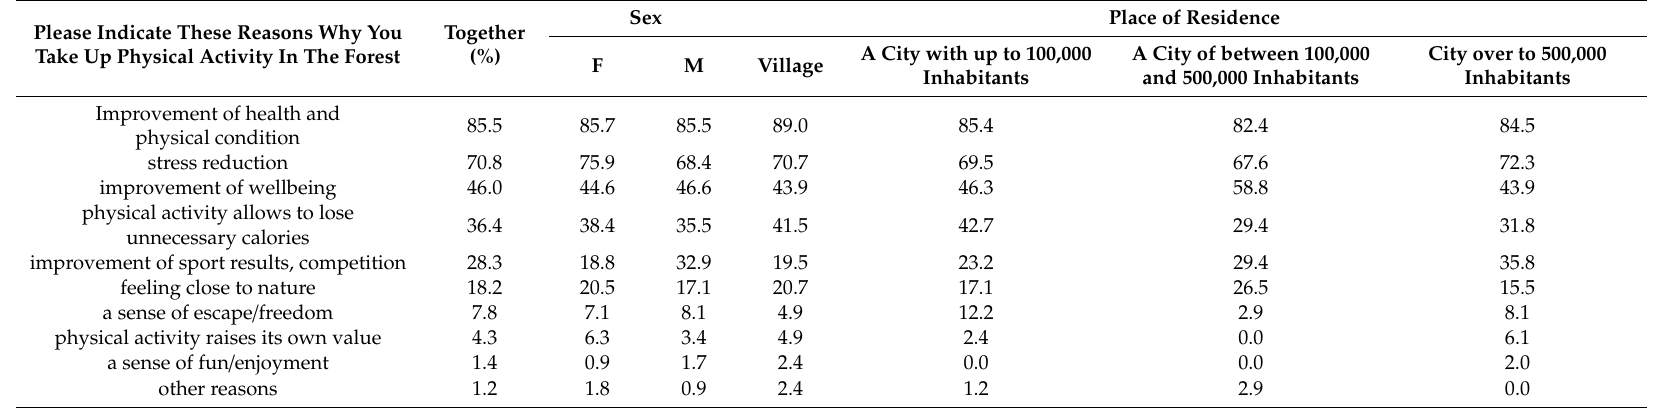
Table 2. Views of respondents on factors determining their physical activity in forests depending on gender and place of